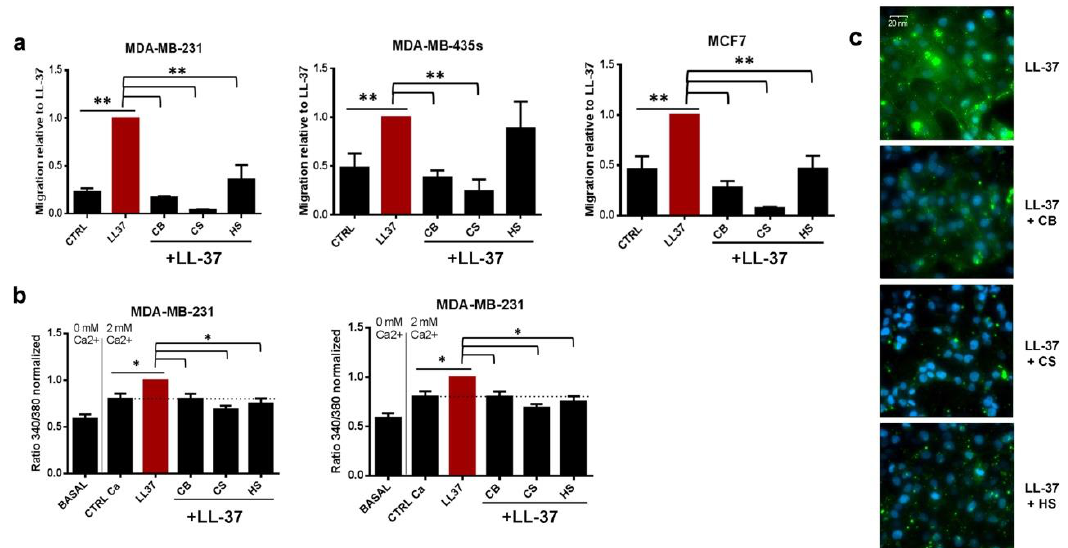
Figure 2. Glycoaminoglycans (chondroitin sulfate and heparin) inhibit LL-37 induced-calcium entry and migration and reduce its attachment to the cell surface. ( a ). Migration of MDA-MB-231, MDA-MB-435s and MCF7 cell lines induced by LL-37 and incubated or not with di ff erent glycoaminoglycans (CB—chondroitin sulfate B at 0.5 mg / mL, CS—chondroitin sulfate from shark cartilage at 0.5 mg / mL, HS—heparin at 50 UI / mL (N = 4)). ( b ) Calcium entry in MDA-MB-231 and MDA-MB-435s induced by LL-37 (10 µ g / mL) with or without glycoaminoglycans with concentrations as used for migration (N = 3). ( c ) Immunofluorescence labeling with anti-LL-37 [22] plus secondary antibody (Alexa488-green) on MDA-MB-231, incubated with or without di ff erent glycoaminoglycans with same concentrations as used for migration. Nuclei were labeled by DAPI (in blue). Magnification 400 × . Data (migration and calcium entry) are normalized to LL-37. Statistics: ** p < 0.01, * p < 0.05, relative to LL-37 and relative to control without LL-37.